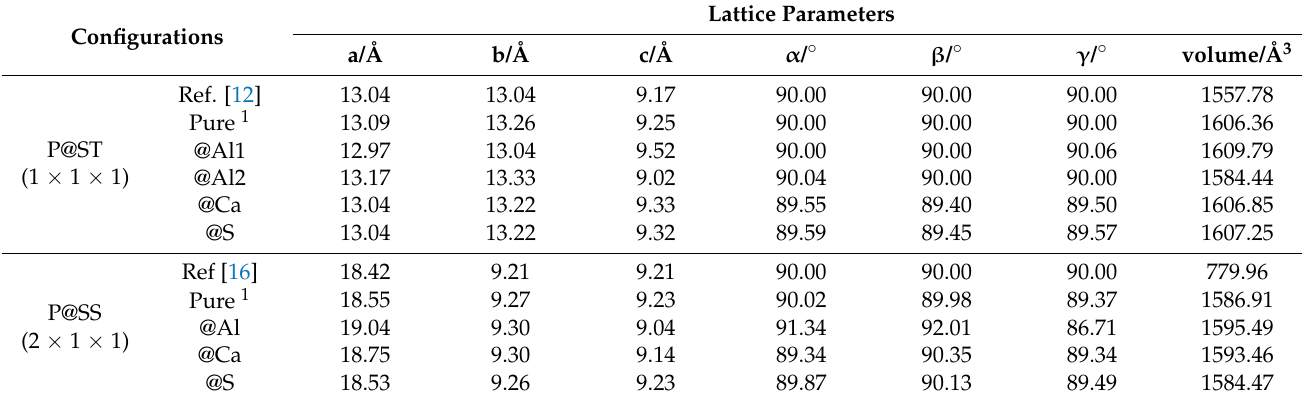
Lattice Parameters